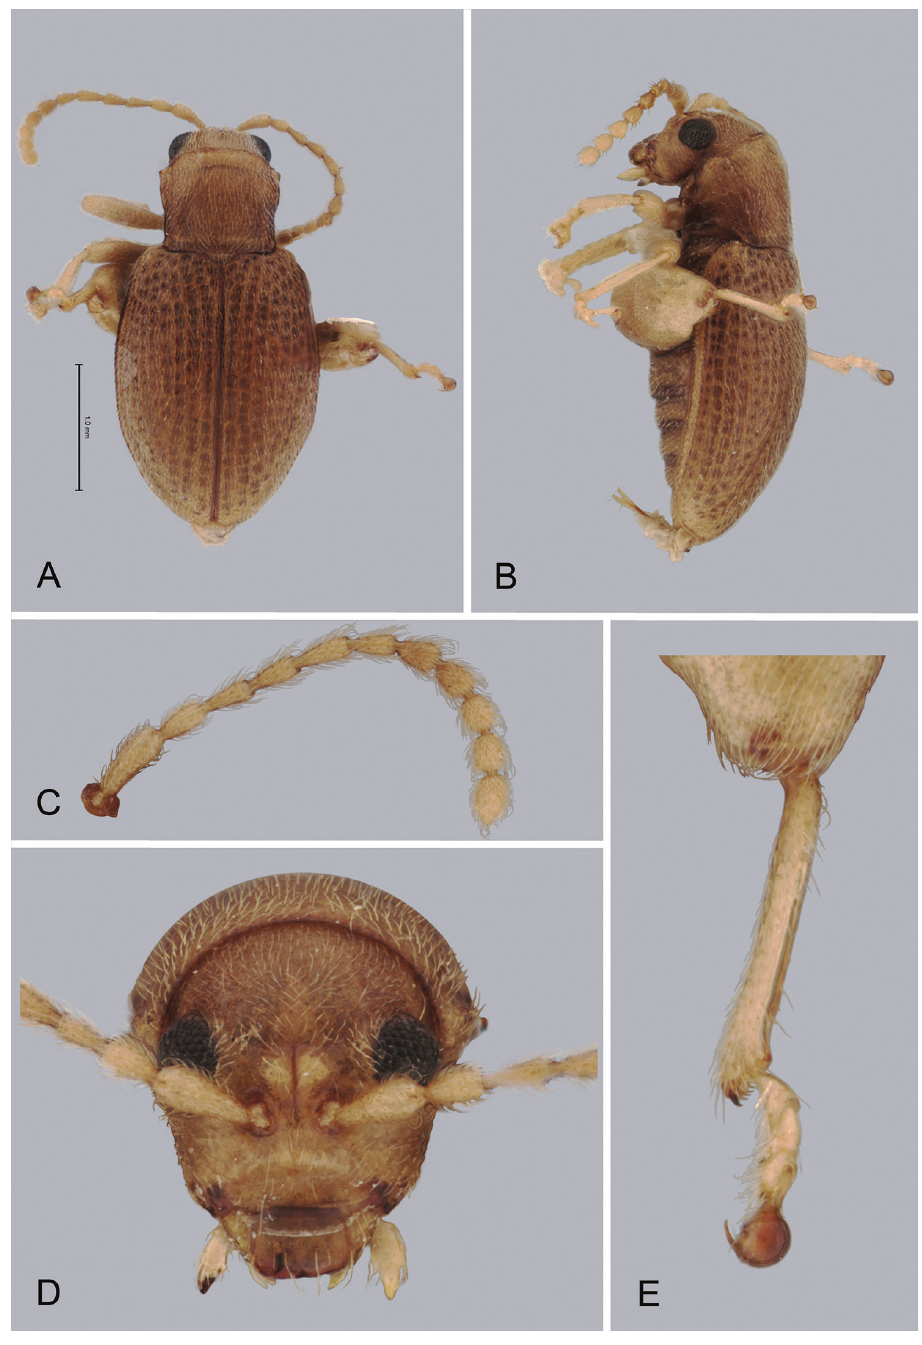
Figure 3. Andersonoplatus baru . A Habitus dorsal B Habitus lateral C Antenna D Head, frontal view E Hind